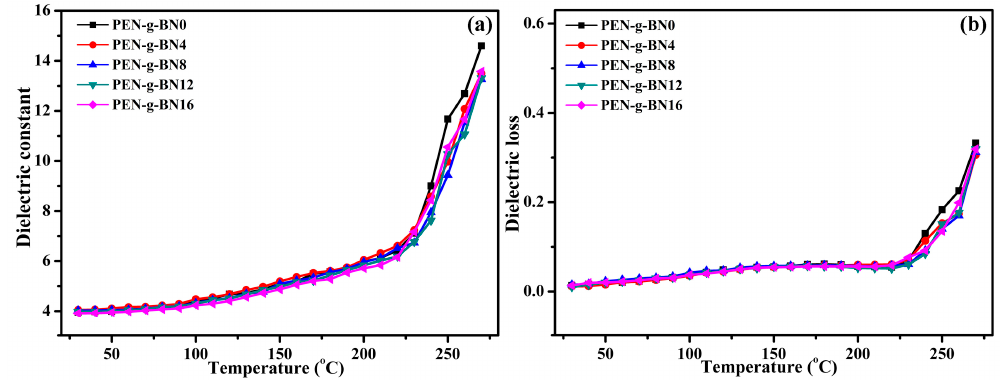
Figure 8. Temperature dependence of dielectric constant ( a ) and dielectric loss ( b ) of the PEN-g-BN hybrids.